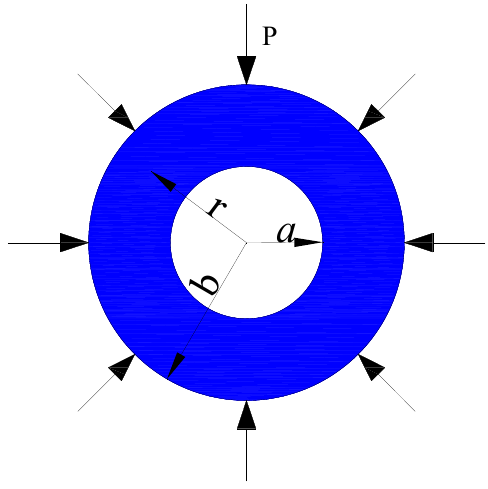
Figure 10. Mechanical model of frozen wall.